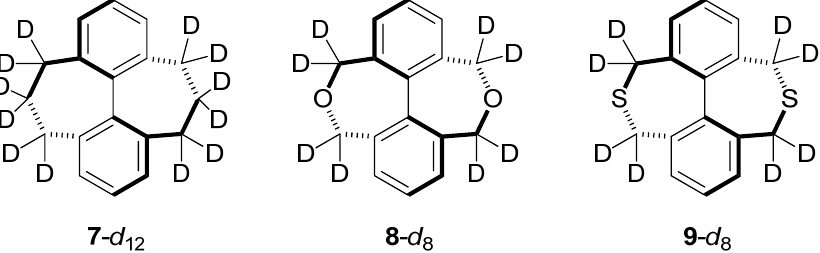
Figure 5. Analogs for in silico comparison with Mislow’s doubly-bridged ketone.